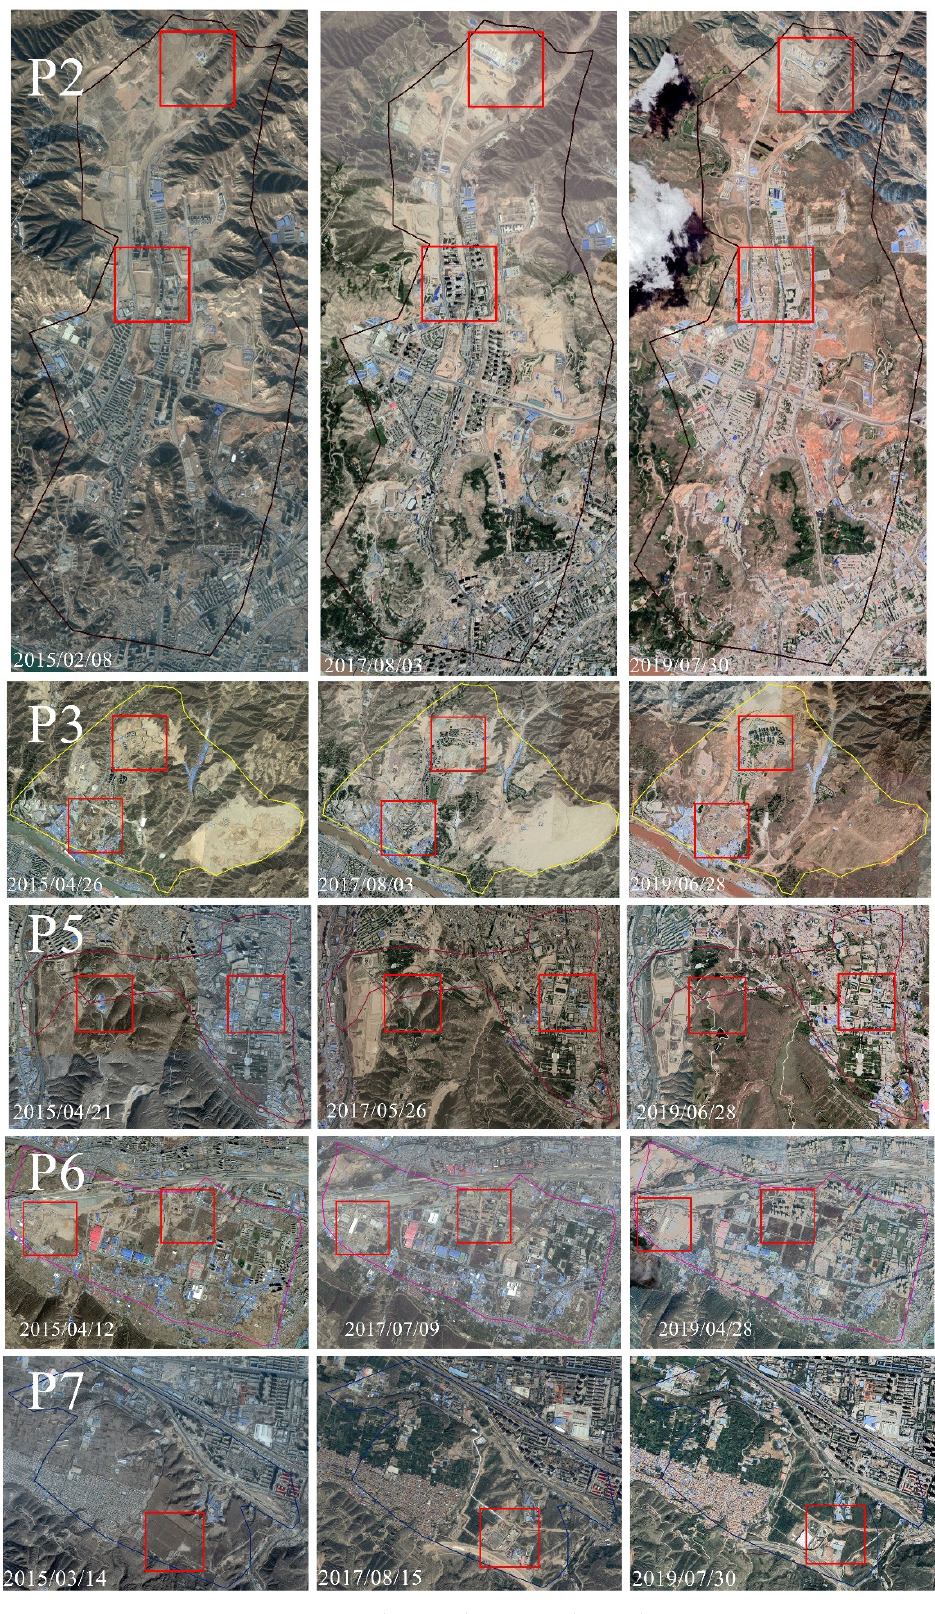
Figure 13. Land cover changes in the study area.